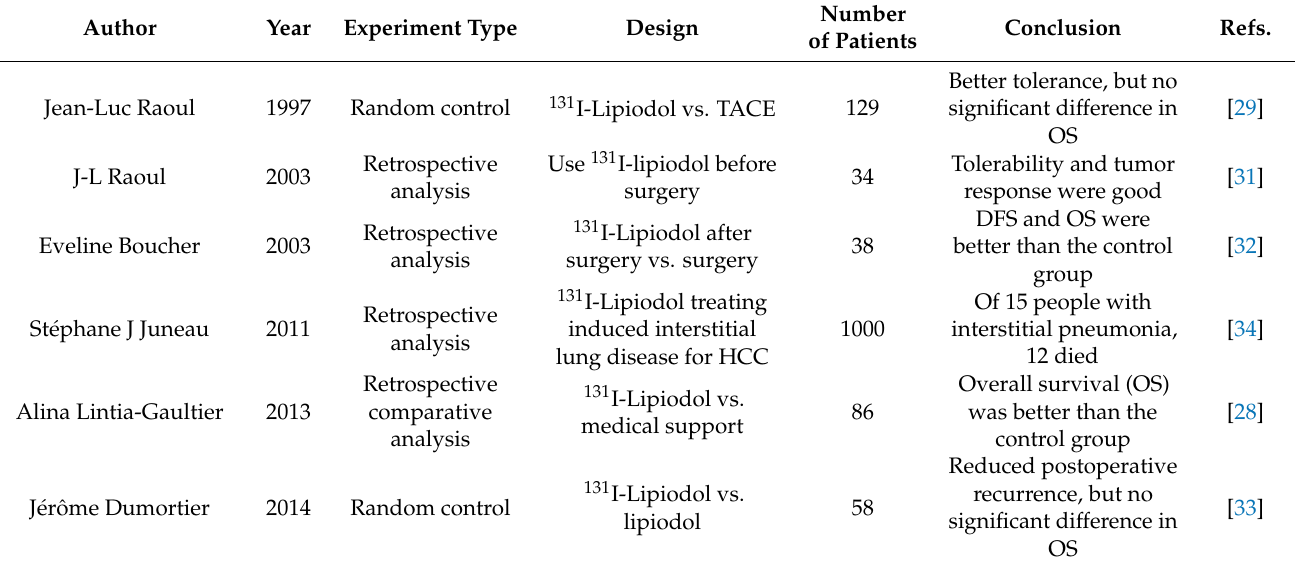
Table 2. Advances for treatment of HCC using 131 I-lipiodol